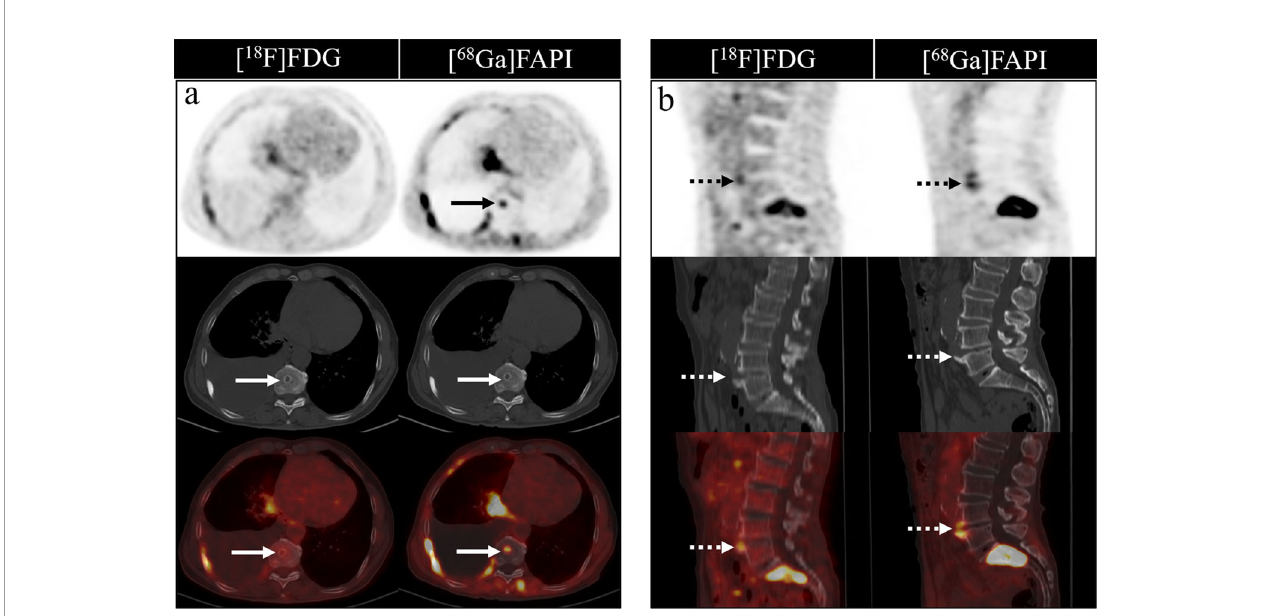
FIGURE 6 | Characteristic fi ndings of Schmorl Node (A) and degenerative osteophyte (B) . The Schmorl Node in the patient with lung cancer (A) shows tracer uptake on the [ 68 Ga]Ga-DOTA-FAPI-04 PET/CT, while no uptake on the [ 18 F]FDG PET/CT. The degenerative osteophyte in the patient with lung cancer (B) shows tracer accumulation on [ 18 F]FDG and [ 68 Ga]Ga-DOTA-FAPI-04 PET/CT.